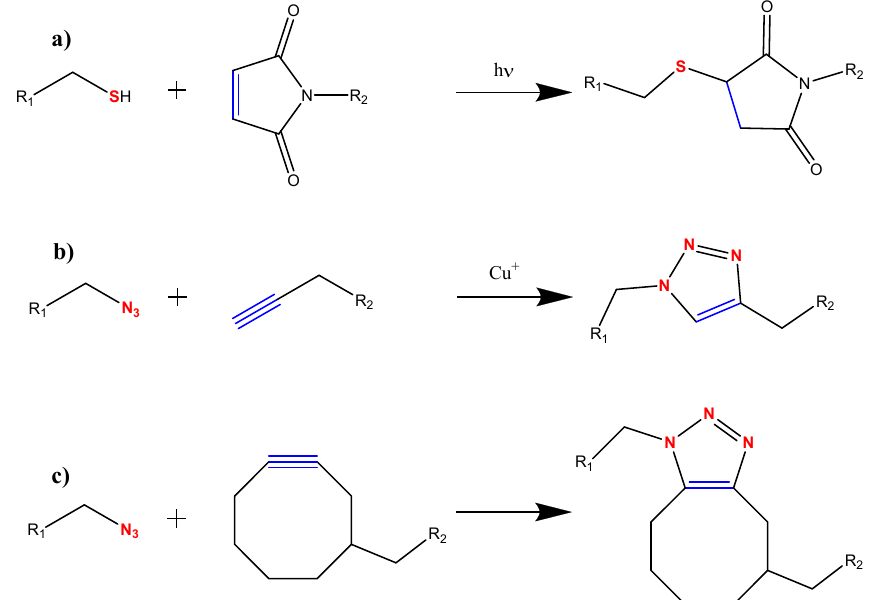
Figure 16. General reaction schemes for ( a ) Radical-mediated thiol-ene click reactions, ( b ) Copper-catalyzed Azide Alkyne Cycloaddition (CuAAC), ( c ) Strain-Promoted Azide Alkyne Cycloaddition (SPAAC). R 1 and R 2 can represent either the biomolecule or the nanofiber.